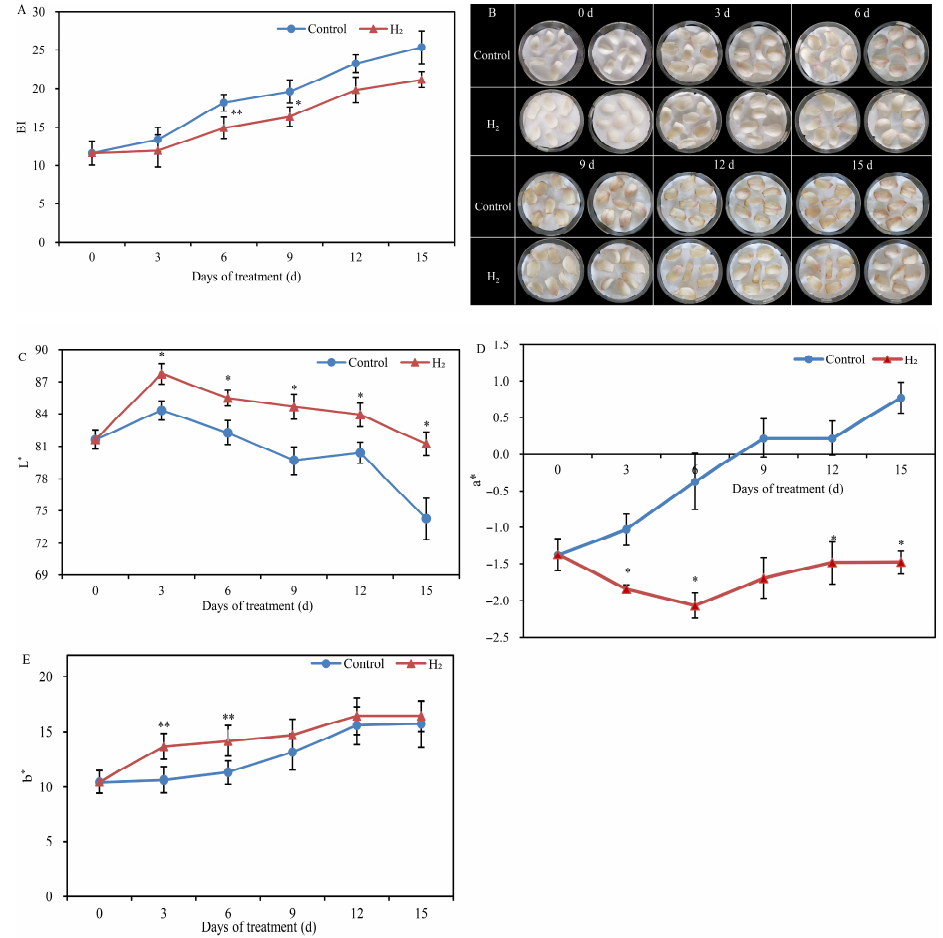
Figure 1. Changes in the browning index (BI) ( A ), phenotypic ( B ), L* value ( C ), a* value ( D ) and b* value ( E ) of Lanzhou lily scales fumigated with H 2 at room temperature. The error bars indicate the means ± SE (n = 15 scales for each of three independent experiments). Values with asterisks are significantly different (* p < 0.05; ** p < 0.01) from the control treatment on the same day according to independent t -test. d: days.